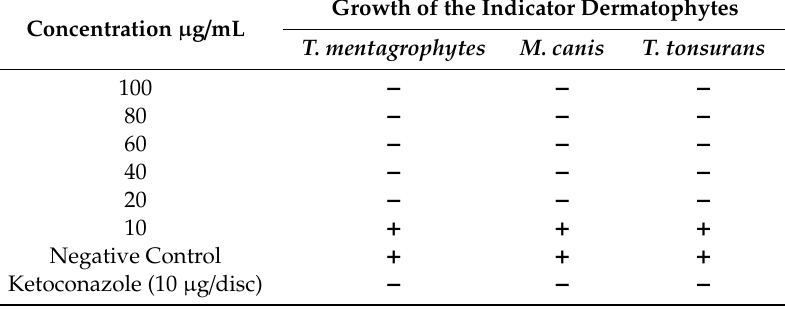
Table 3. It contained starch (20 g / L) as the main carbon source, potassium nitrate (2 g / L) as the main nitrogen source, and dipotassium hydrogen phosphate (1 g / L) as main phosphorus source and NaCl at 0.5 g / L. Table 3. Minimum inhibitory concentration (MIC) values of the antifungal compound produced by S. atrovirens